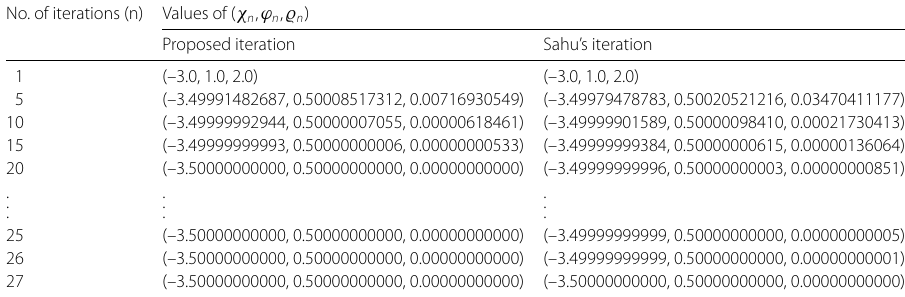
Table 1 Iterative values with starting point (–3,1,2)